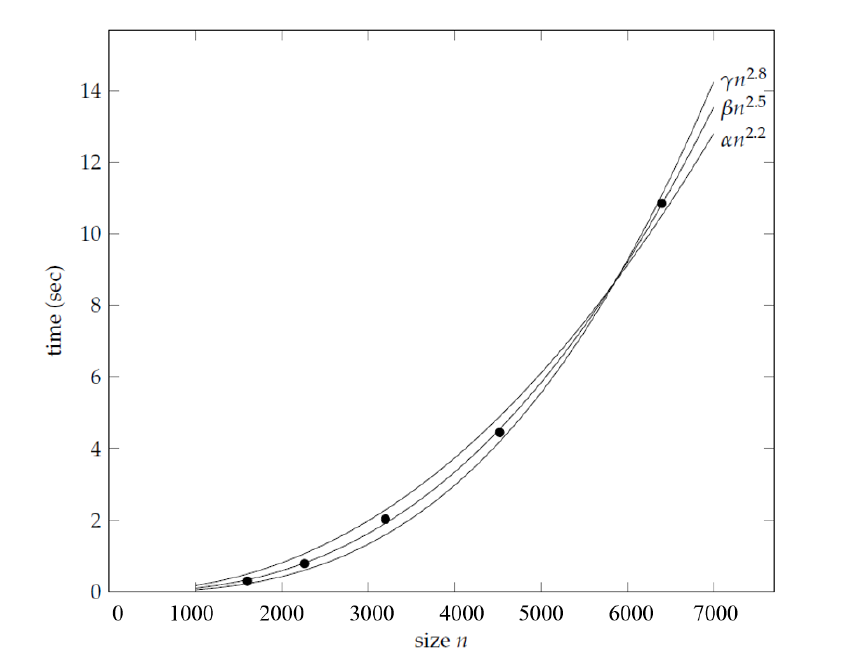
Figure 2. Plots of possible fittings of the time for finding the first best move (GEO instances). The multiplicative constants are α (cid:39) 4.44 × 10 − 8 , β (cid:39) 0.33 × 10 − 8 , and γ (cid:39) 0.02 × 10 − 8